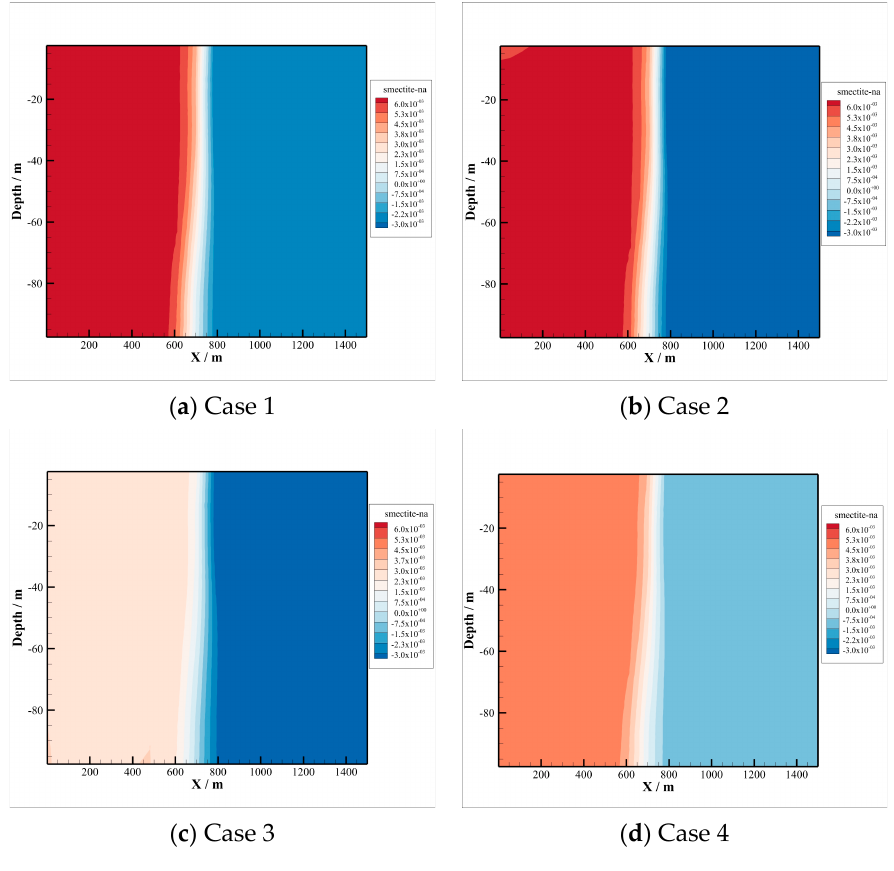
Figure 17. Smectite-Na precipitation in different cases.